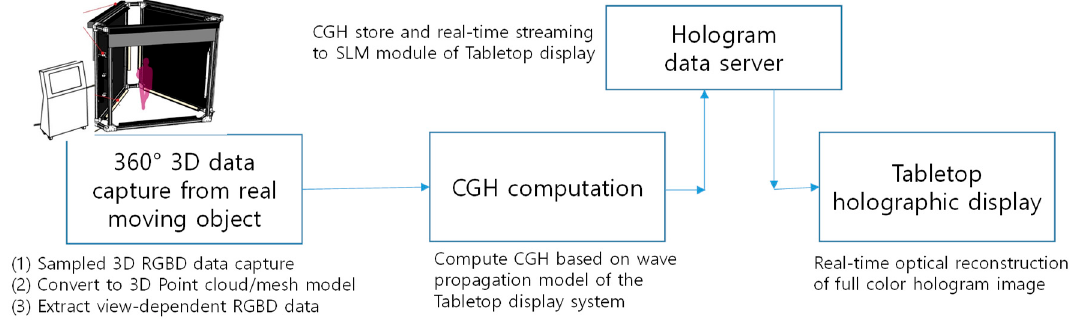
Figure 8. Signal processing chain of the tabletop holographic display system.